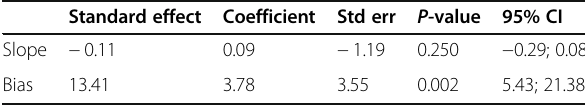
Table 4 Egger ’ s test for small-study